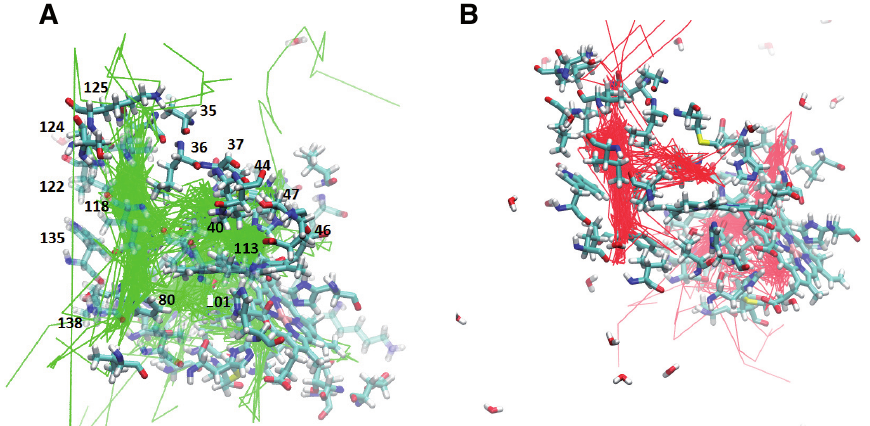
Figure 4. A. F97L trajectories highlighting the internal cavities. B. F07V trajectories highlighting the internal cavities. The internal cavities in each structure can be compared with the B, Xe4, Xe2, and Xe1 cavities shown in Figure 2B.